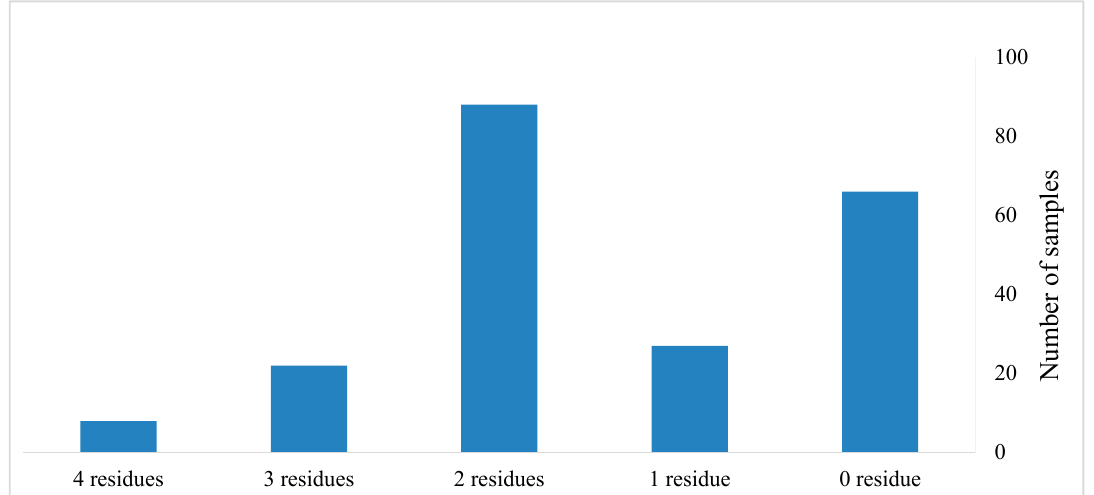
Figure 2. The co-occurrence of pesticide residues in the tested samples.